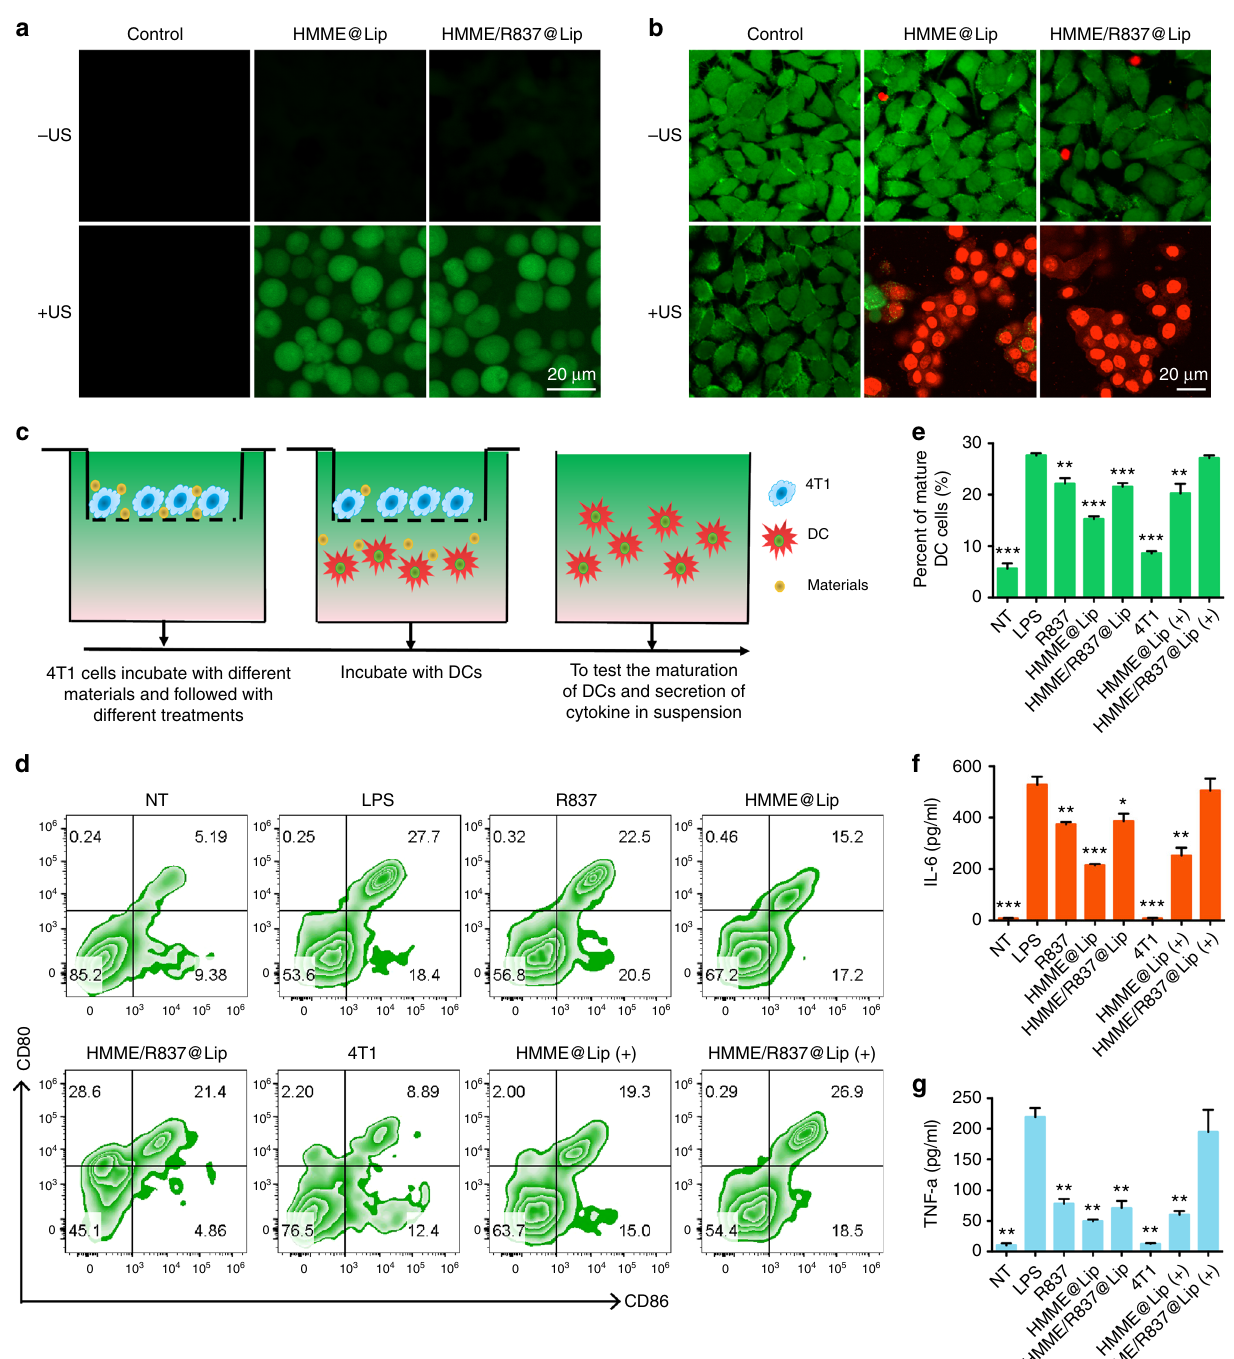
Fig. 3 In vitro toxicity of HMME/R837@Lip upon US irradiation against 4T1 cancer cells and stimulation of in vitro immune response. a CLSM images of 4T1 cells stained with DCFH-DA after different treatments: control (without any treatment), HMME@Lip only, HMME/R837@Lip only, US only, HMME@Lip combined with US irradiation and HMME/R837@Lip combined with US irradiation (scale bar = 20 μ m); b CLSM images of 4T1 cells stained with Calcein-AM and PI after various treatments: control (without any treatment), HMME@Lip only, HMME/R837@Lip only, US only, HMME@Lip combined with US irradiation and HMME/R837@Lip combined with US irradiation (scale bar = 20 μ m); c the design scheme of the transwell system experiment. 4T1 cells and their residues were placed in the upper compartment and DCs were cultured in the lower compartment; d the percentage of mature DCs (CD11c + CD80 + CD86 + ) was analysed by fl ow cytometry after different treatments for 20 h in the transwell system; e – g quanti fi cation of the level of DC maturation ( e ) and the secretion of IL-6 ( f ) and TNF- α ( g ) in DC suspensions. Data are expressed as means ± SD ( n = 3). Statistical signi fi cances were calculated via Student ’ s t test, * p < 0.05, ** p < 0.01 and *** p <